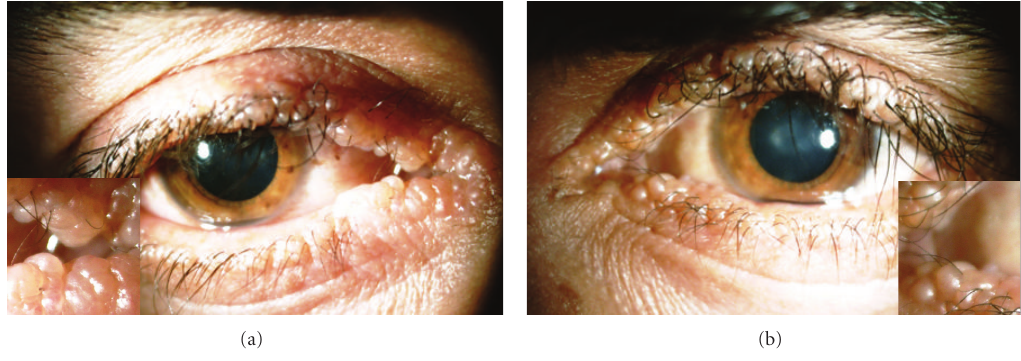
Figure 1: Moniliform blepharosis in (a) right and (b) left